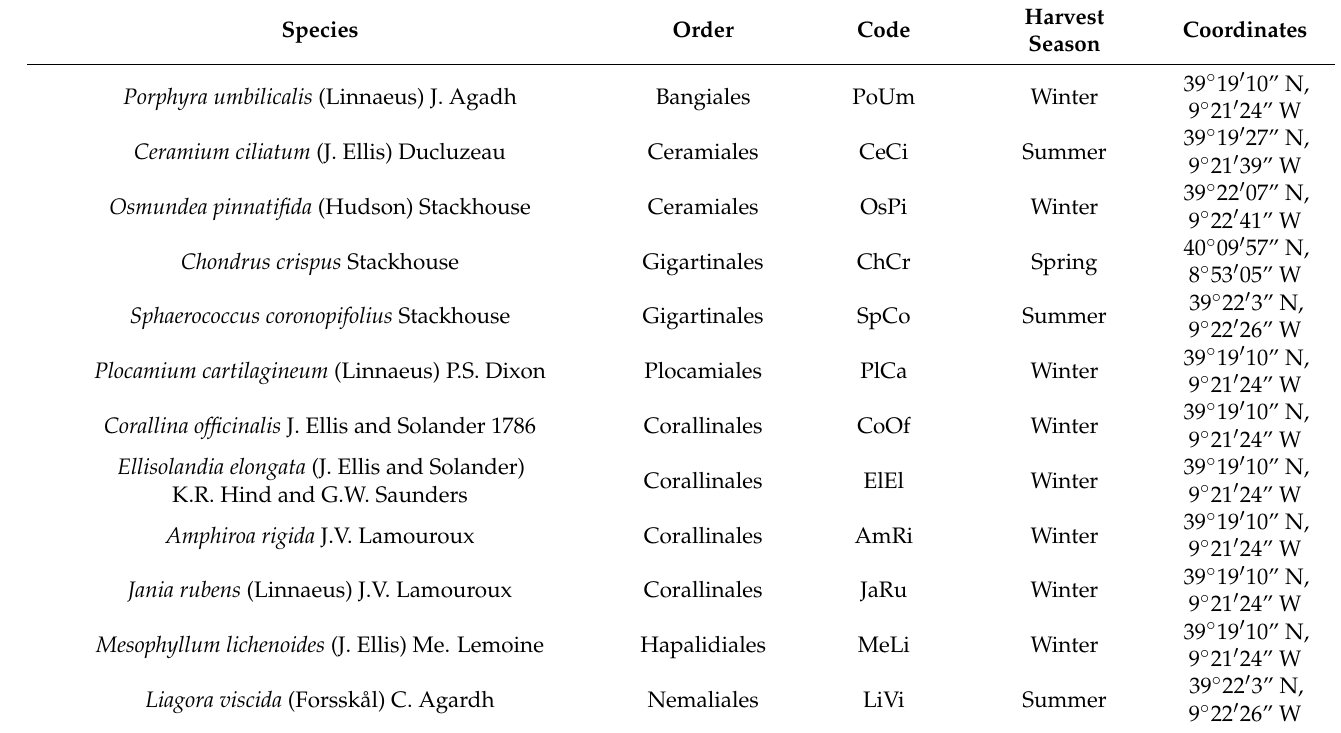
Table 1. List of the species studied, corresponding code names and harvesting season. Species Order Code